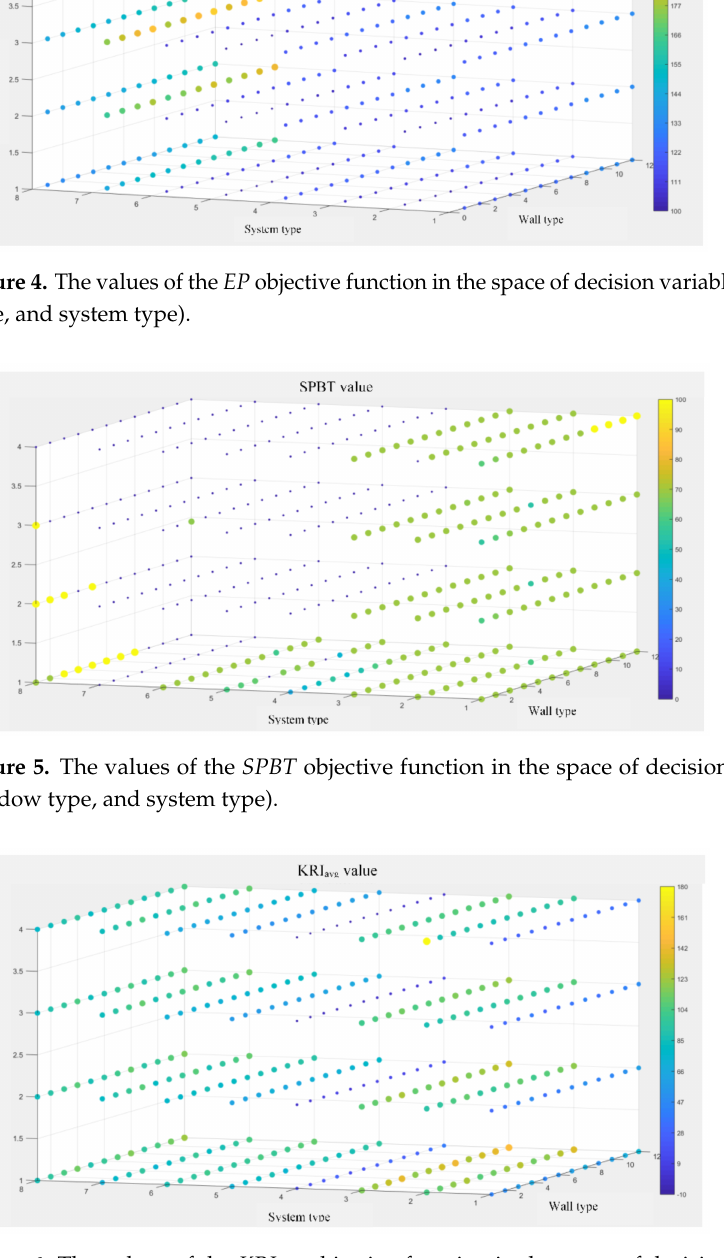
Figure 6. The values of the KRI avg objective function in the space of decision variables (wall type, window type, and system